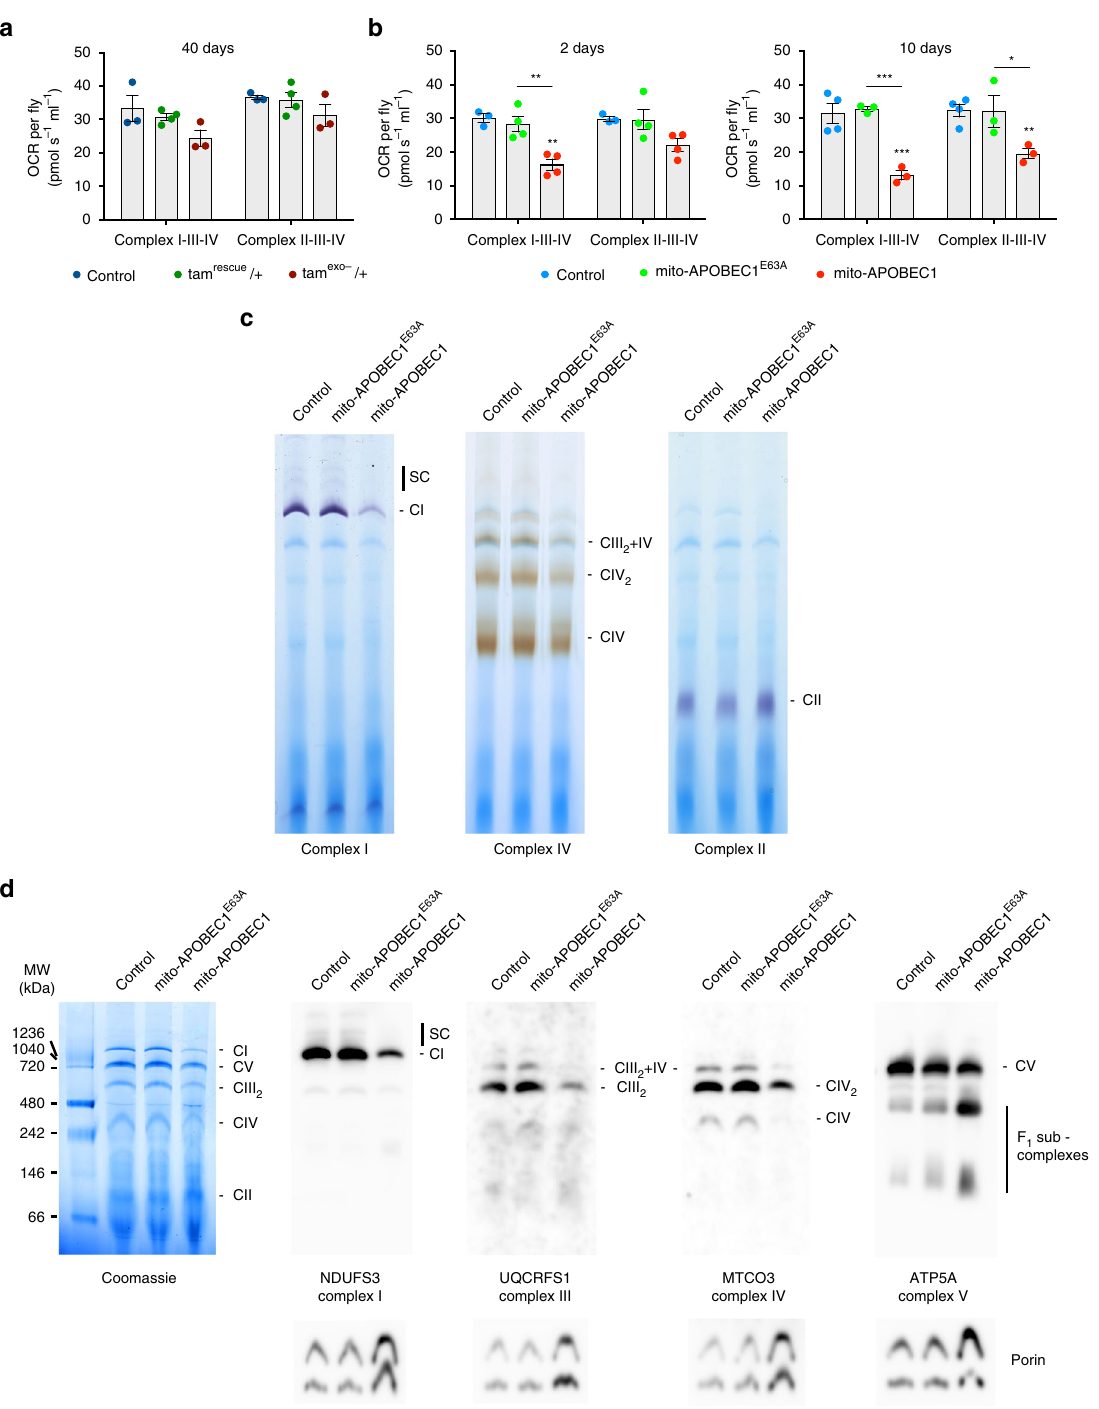
Fig. 5 Mitochondrial respiration is compromised in mito-APOBEC1 but not tam exo − fl ies. Respiratory activity was measured in a maternally inherited tam exo − and b mito-APOBEC1 fl ies and respective controls by Complex I- or Complex II-linked oxygen consumption rates (OCR) in isolated mitochondria from fl ies at the indicated age. Values were normalised per fl y. Charts show mean ± SEM, n = 3 biologically independent samples. Statistical analysis used one-way ANOVA with Sidak ’ s multiple comparisons test; * P < 0.05, ** P < 0.01, *** P < 0.001. All other comparisons are non-signi fi cant (NS). Blue Native-PAGE followed by in-gel activity assay ( c ) or immunoblotting ( d ) of mitochondrial-enriched samples from mito-APOBEC1 fl ies. c Gels were incubated for Complex-I or Complex-II activities (violet), or Complex-IV activity (brown). Equal amounts of total protein were loaded per lane. d Blue-Native gels were Coomassie stained or used for immunoblotting against NDUFS3 ( Dm ND-30; Complex-I), UQCRFS1/Rieske ( Dm RFeSP; Complex-III), MTCO3 ( Dm mt: CoIII; Complex-IV) and ATP5A ( Dm Blw; Complex-V). Anti-Porin was used as a loading control. CI, Complex-I; CII, Complex-II; CIII, Complex-III; CIII 2 , Complex-III dimer; CIV, Complex-IV; CIV 2 , Complex-IV dimer; CV, Complex-V; SC, super-complexes. Source data are provided as a Source Data fi